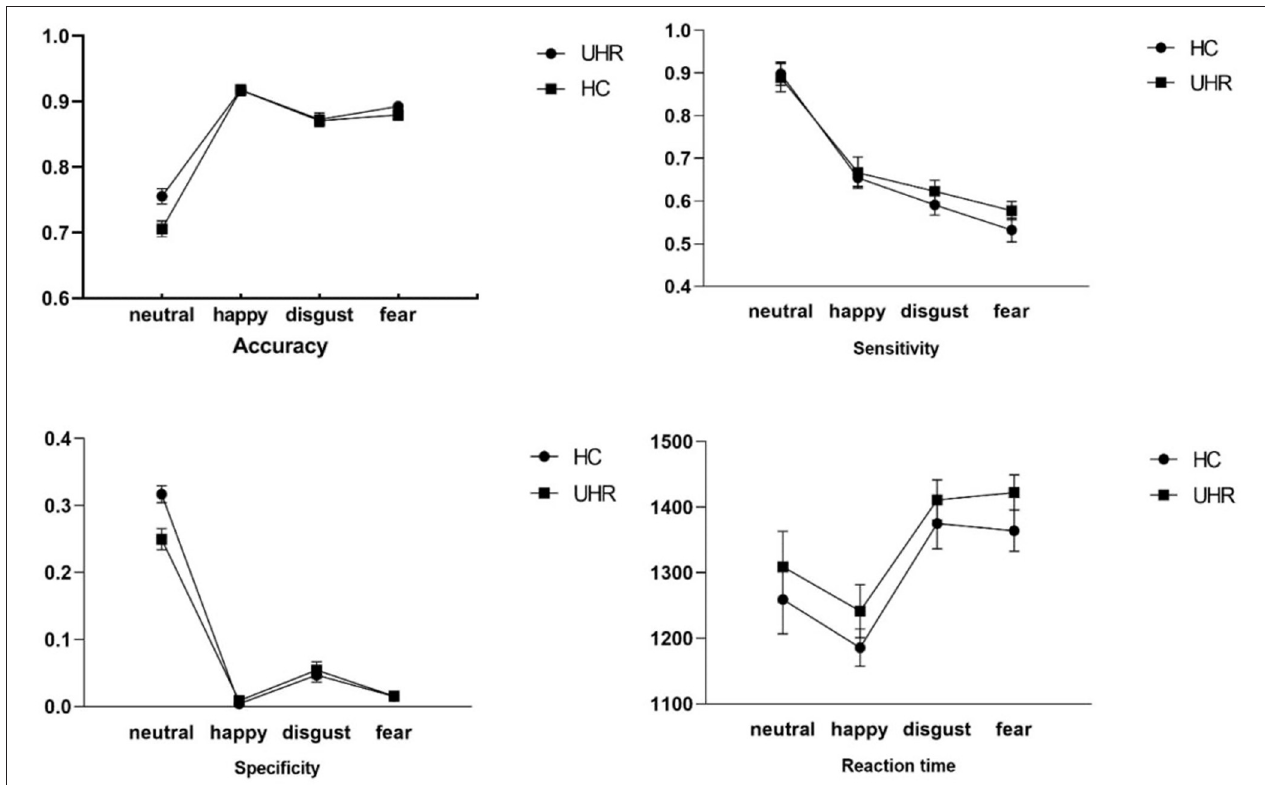
FIGURE 1 | Group comparisons of accuracy, sensitivity, specificity and reaction time during happy, neutral, disgust and fear emotion recognition between UHR and control